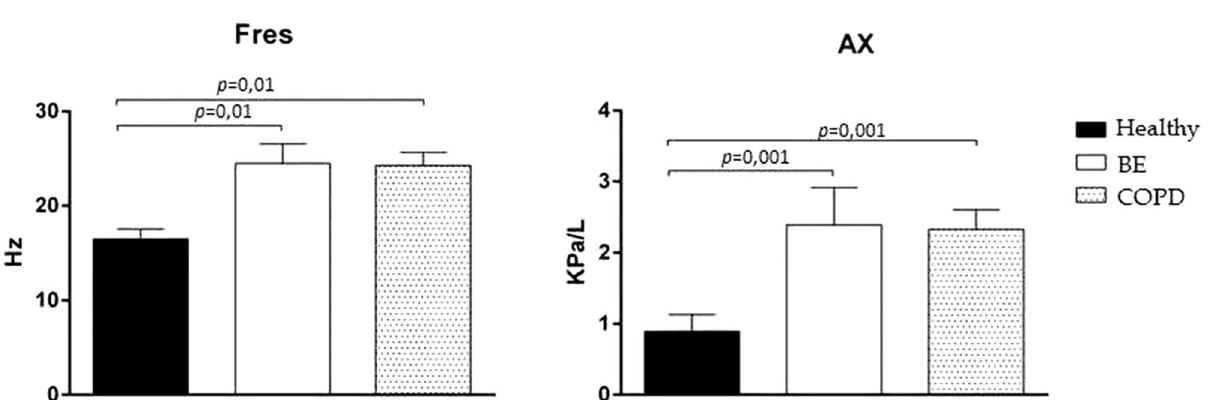
Figure 2. Comparison of resonant frequency (Fres) and rectance area (Ax) in whole-breath, in healthy subjects (black bars), patients with bronchiectasis (BE) (white bars) and chronic obstructive pulmonary disease (COPD) (dotted